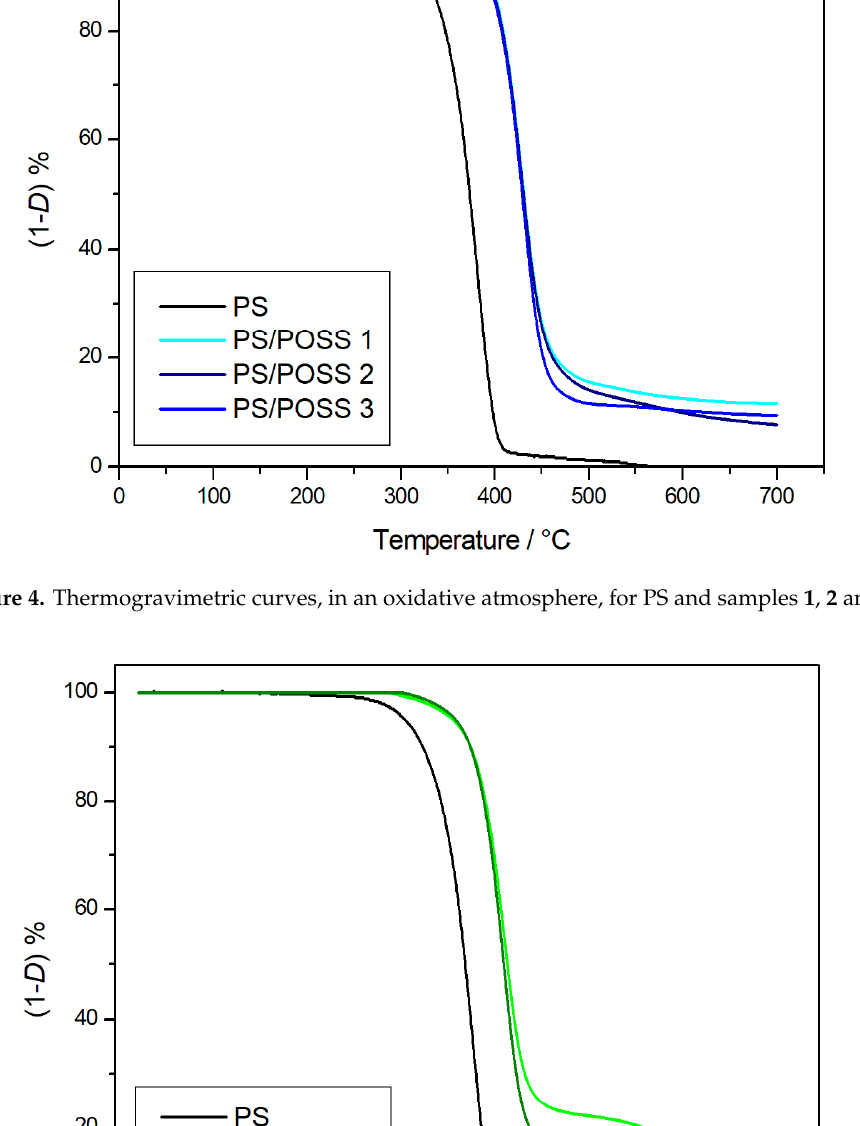
Figure 6. SEM images of PS/POSS 2 nanocomposites.